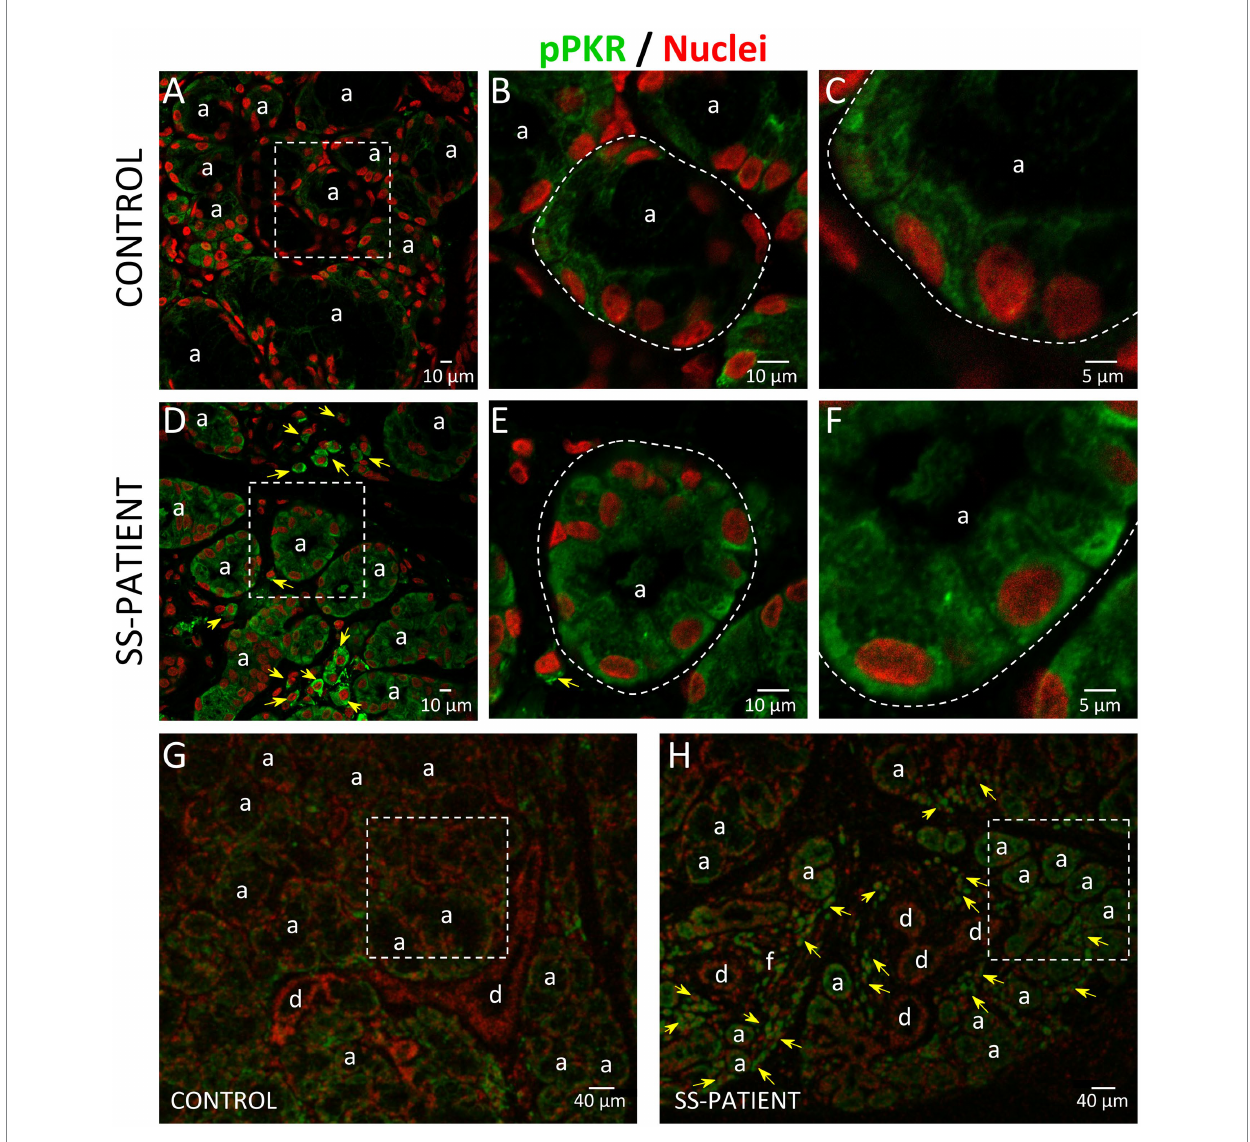
FIGURE 4 Localization of p-PKR in LSGs from controls and SS-patients. (A–C,G) p-PKR (green) staining was mainly observed in the cytoplasm of epithelial cells in LSGs from control subjects. (D–F,H) Stronger p-PKR (green) staining was observed in the cytoplasm of epithelial cells and plasma cells (yellow arrows) in LSGs from SS-patients. (A,D) Higher magnifications of regions surrounded by broken lines in G and H, respectively. (B,C,E,F) Higher magnifications of regions surrounded by broken lines in A and B, respectively. Nuclei (red) were counterstained with Hoechst-33342. a: acini; d: duct; f: focus of inflammatory cells. Bars A, B, D, and E 10: μ m; C and F: 5 μ m; G and H: 40 μ